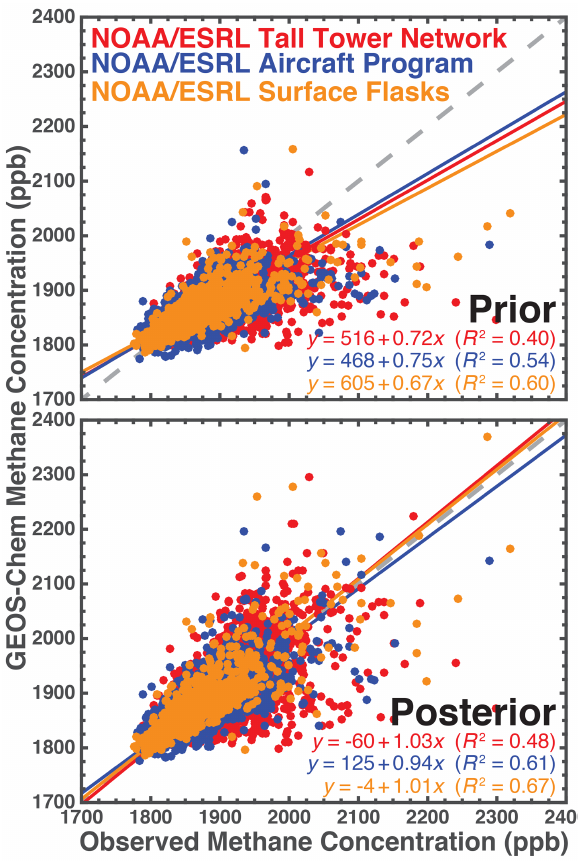
Figure 5. Evaluation of the GOSAT inversion of methane emis- sions for North America with independent data sets. The scatter- plots show comparisons of GEOS-Chem (1/2 ◦ × 2/3 ◦ resolution) methane concentrations with observations from the NOAA/ESRL tall tower network (red), NOAA/ESRL aircraft program (blue), and the NOAA/ESRL surface flask network (orange), using prior emissions (top) and posterior emissions (bottom). The 1:1 lines (dashed) and reduced-major-axis (RMA, solid) linear regressions are also shown. RMA regression parameters are shown inset and correspond to the statistics of Table